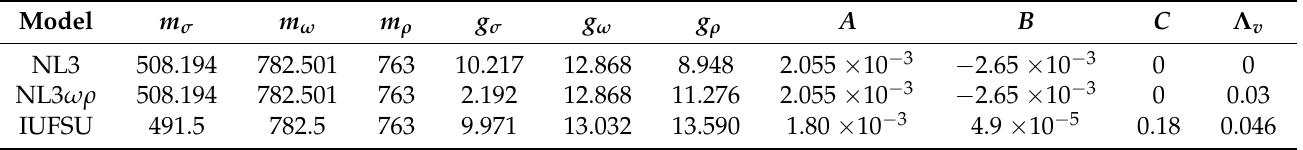
Table 1. Parameter sets used in this section-all meson masses and A are given in MeV, Λ v = α 3 (cid:48) /2 and M = 939 MeV. Model